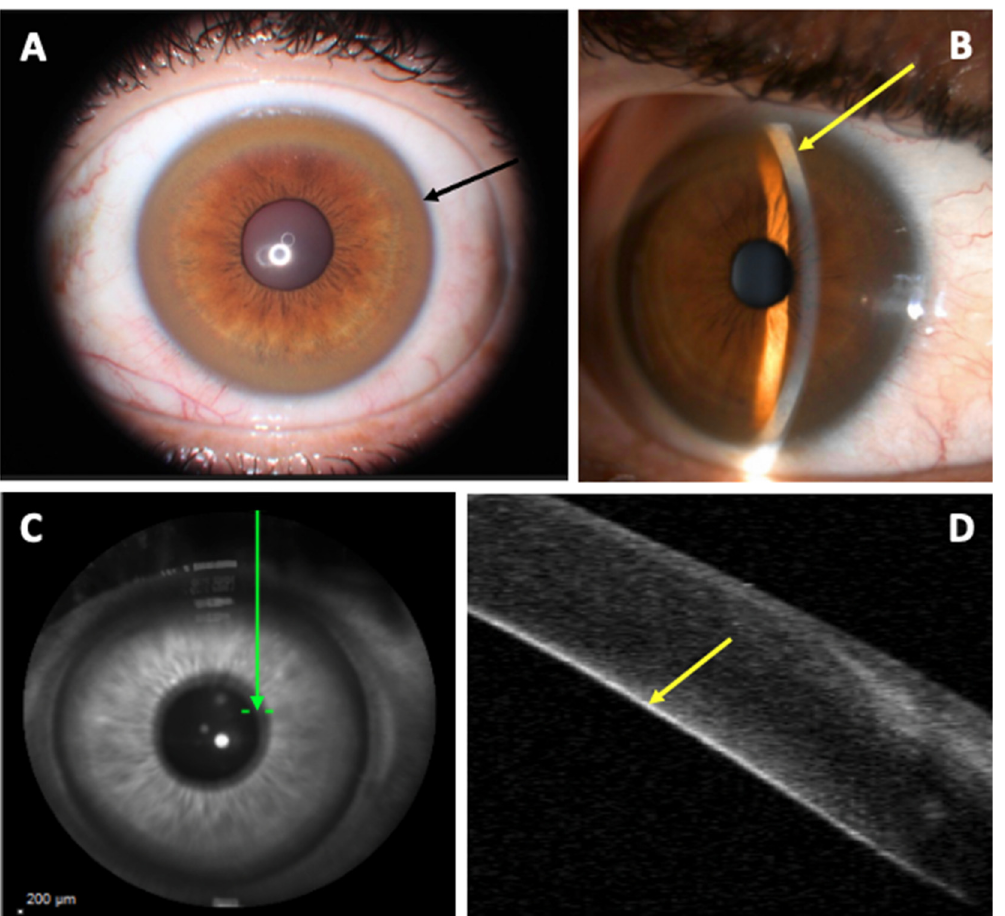
Figure 2. Kayser–Fleischer Ring. ( A ): Slip-lamp examination showing a diffuse circumferential Kayser–Fleischer ring in the left eye (black arrow); ( B ): Slit-lamp examination: visualization of the copper deposit at the posterior part of the cornea in fine slit (yellow arrow); ( C ): Corneal B-scan localization (Spectralis; Heildelberg Engineering) (green arrow); ( D ): marked hyperreflectivity of the posterior part of the cornea corresponding to the copper deposit (yellow arrow).